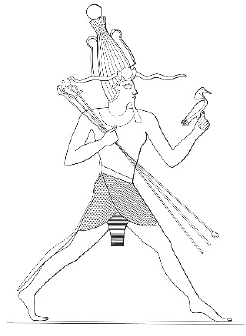
Figure A1. Egyptian king during the so-called Vogellauf ritual. Drawing by Lucie Vařeková. Moreover, ancient Egyptian texts (mostly of cultic nature) bear also some useful information of the Northern Bald Ibis migration. In the royal tombs of the New Kingdom, migratory birds coming from the north are viewed as messengers from the hereafter, i.e., souls of the ancestors. The society of the blessed dead (Akhu) also had its own hierarchy structured similarly to the world of the living, the deceased king being at the top of the Akh spirits. The strictly hierarchical structure of the Akh society with only one entity at the very top may have not only reflected the structure of human society but also stemmed from the well-observed V-formation used by the birds during migration. It is noteworthy, that the study of the ancient Egyptian population and cultural significance of the Northern Bald Ibis is particularly important because very different reasons must have been behind the bird’s disappearance from ancient Egypt. None of the above-mentioned probable causes for the species extinction in 16th century Europe (Little Ice Age or hunting) and in the modern Middle East (DDT) had occurred in Egypt in the 2nd millennium BCE.